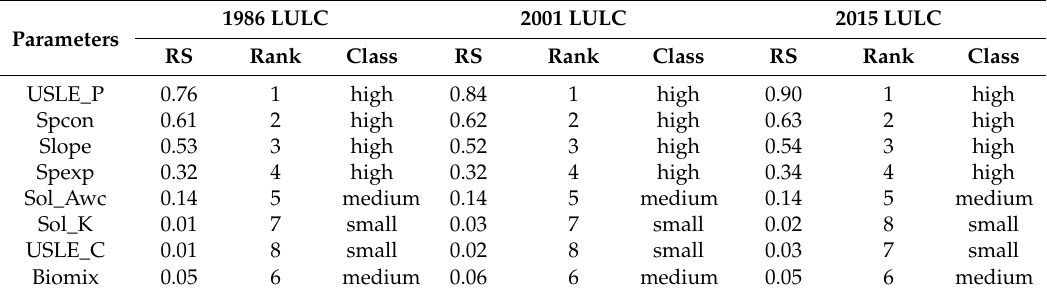
Table 5. SWAT parameters and their relative sensitivity values under varying LULC for sediment